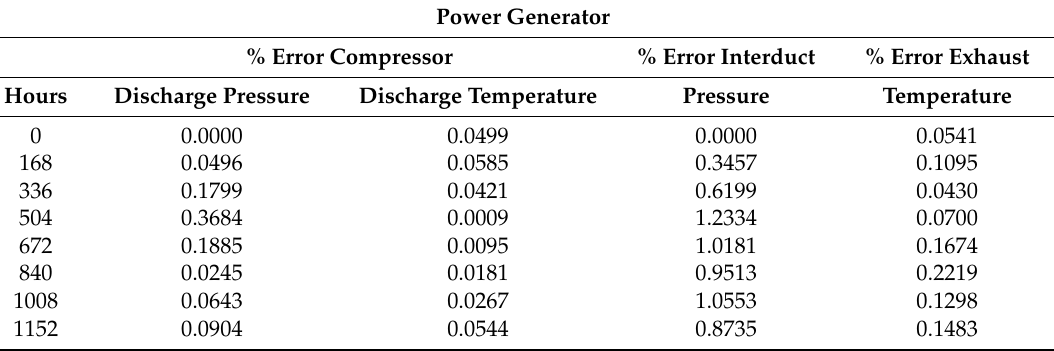
Table 1. Error between fitted and simulated data at high power operation (power